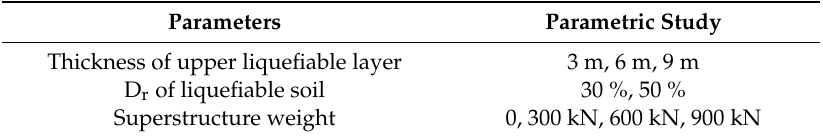
Table 3. Selected parameters in a parametric study.